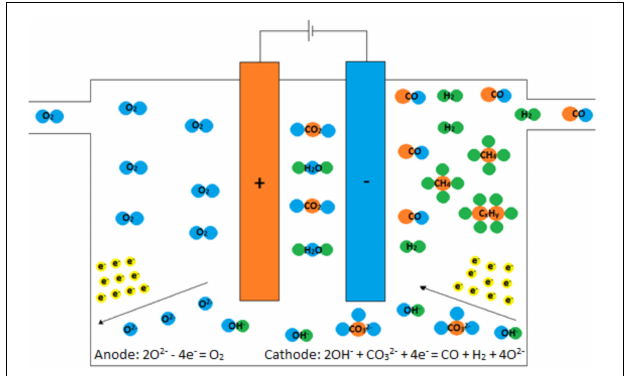
FIGURE 7 | Scheme of the electrolysis system, redrawn from Liu et al. (2017).